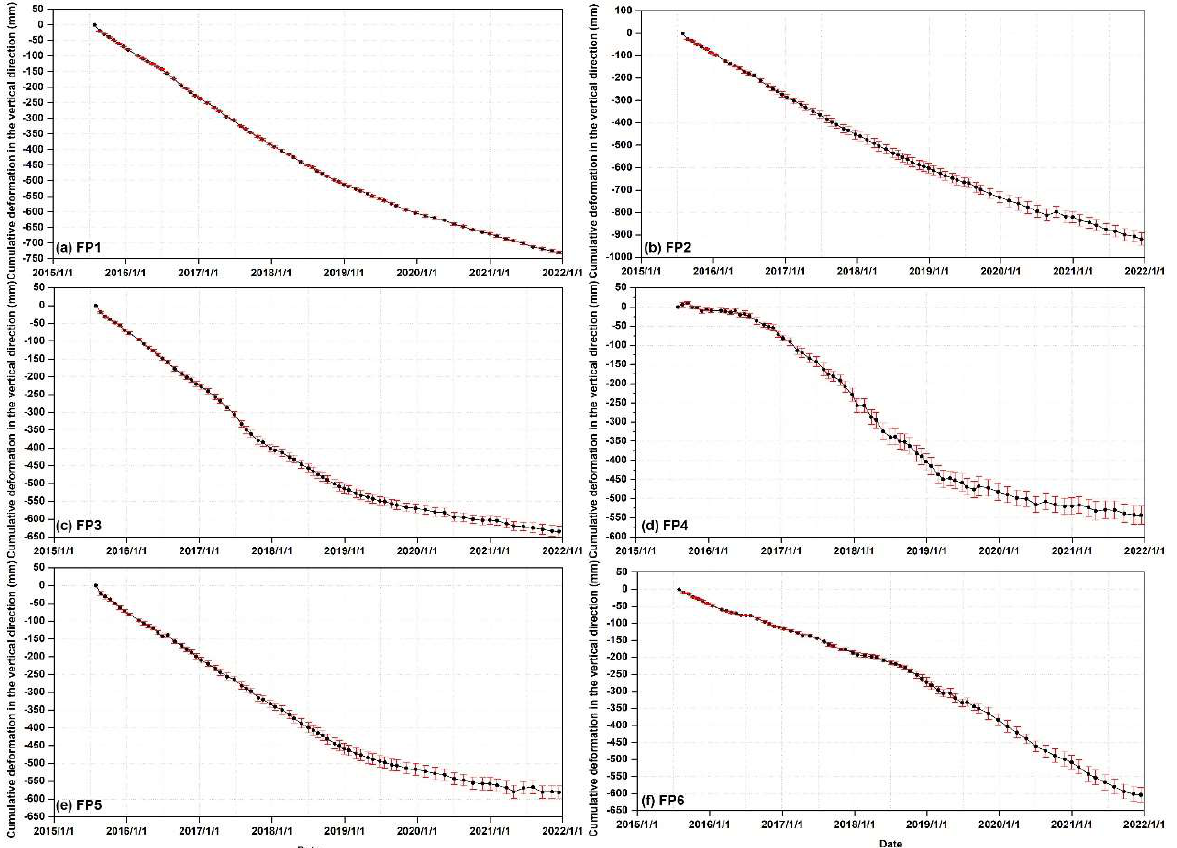
Figure 7. Annual Deformation of feature points located at typical deformed regions of Jinzhan (FP1~FP2), Heizhuanghu (FP3), Lucheng (FP4), Liyuan (FP5) and Taihu (FP6). Here the point targets within a 100-m radius buffer zone are selected to obtain the corresponding uncertainty of the InSAR- derived deformation. The error bar in each point represents the uncertainty of 1σ.